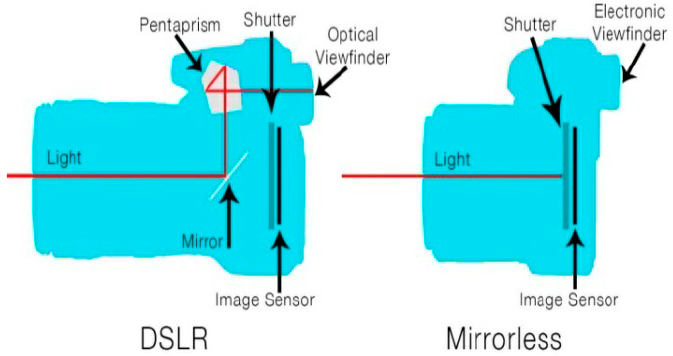
Figure 15. DSLR and mirrorless schematic diagram.